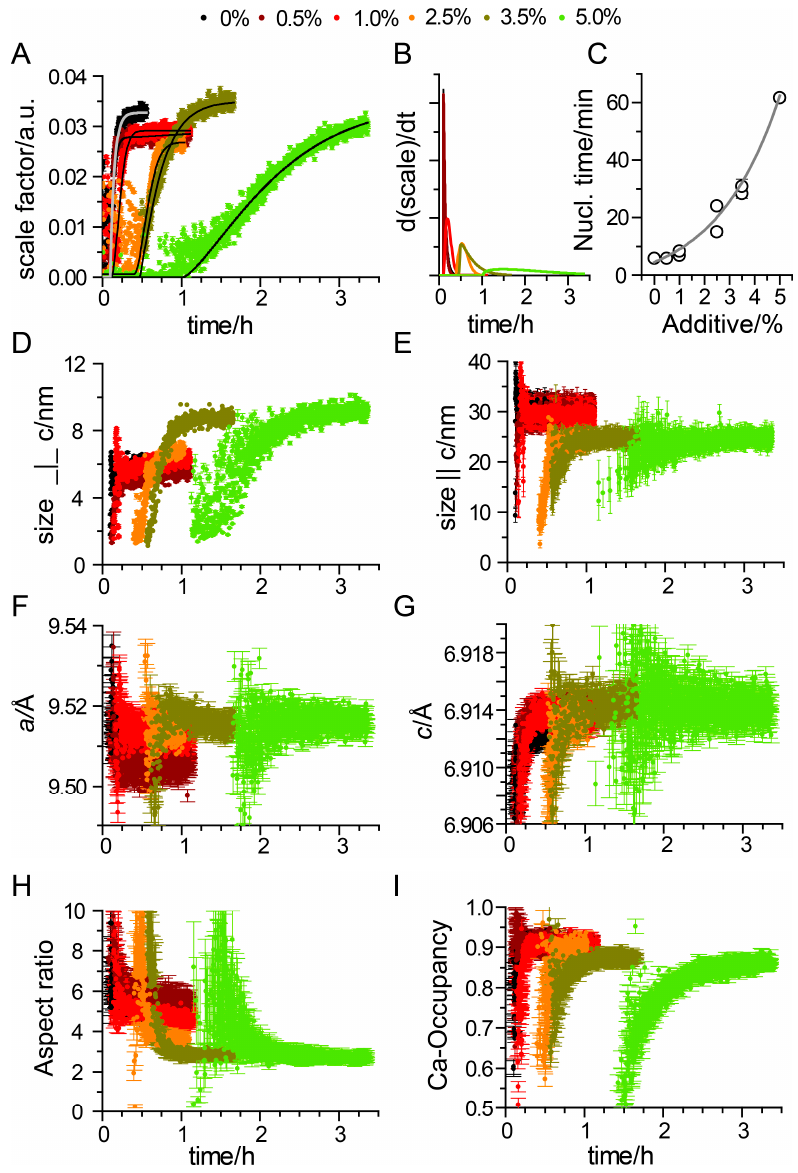
Fig.2 Figure 2. The impact of pyrophosphate on apatite formation kinetics derived from Rietveld refinements. The pyrophosphate concentration is given as molar percent of the calcium concentration. ( A ) The scale factor reflects the amount of crystalline material. The lines are sigmoidal fits to the data; ( B ) rate of growth in the amount of crystalline material as a function of time; ( C ) dependence of nucleation time on the amount of added additive; ( D – I ) time dependence of selected parameters; ( D , E ) crystallite sizes perpendicular and parallel to the c -axis, respectively; ( F , G ) apatite lattice constants; ( H ) crystallite size aspect ratio; and ( I ) calcium